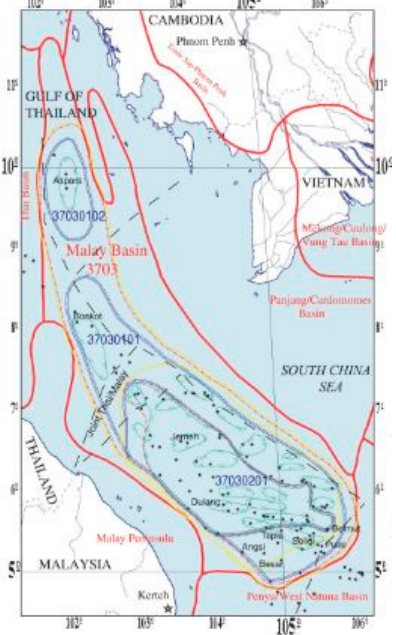
Figure 1. Malay Basin in South China Sea [6].